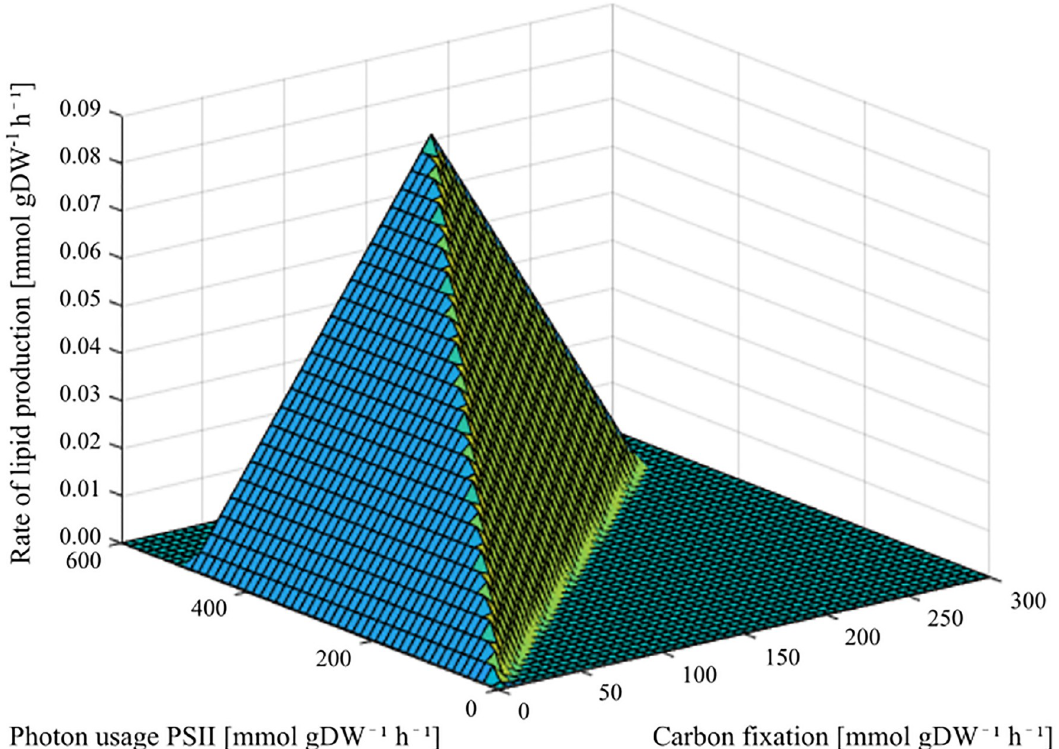
Fig 4. Phenotype phaseplane showing the dependency of lipid synthesis on photosynthesis (photon usage by PSII used as control reaction) and the Calvin-Benson cycle (CO 2 fixation by RuBisCO used as control reaction).